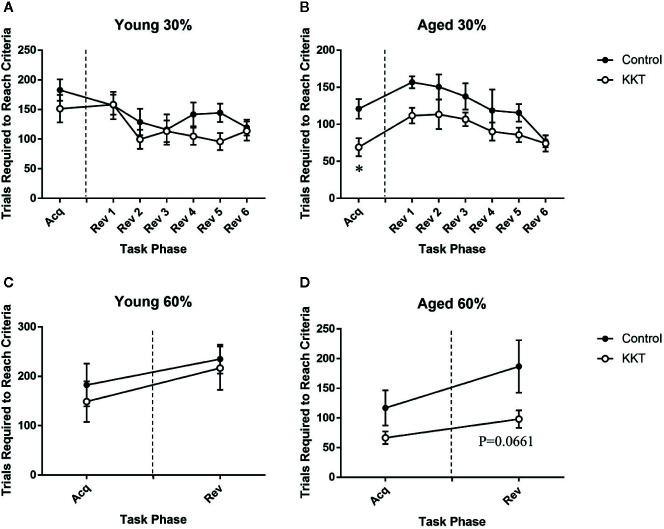
Effects of KKT on cognitive functions. (A, B) Trials required to reach the threshold of 30% success probability in young (A) and aged (B) mice. Unpaired t-tests were used for statistical analysis of the acquisition phase (*: P < 0.05). Data of serial reversal sessions were analyzed by two-way repeated measures ANOVA followed by Bonferroni’s multiple comparison (n = 8). (C, D) Trials required to reach the threshold of 60% success probability in young (C) and aged (D) mice. Data of acquisition and reversal sessions were analyzed with unpaired t-tests. n = 8 (young control), 8 (young KKT), 7 (aged control), and 8 (aged KKT). Note that one mouse of the aged control group failed to reach threshold during the acquisition phase. All data are expressed as mean ± SEM.